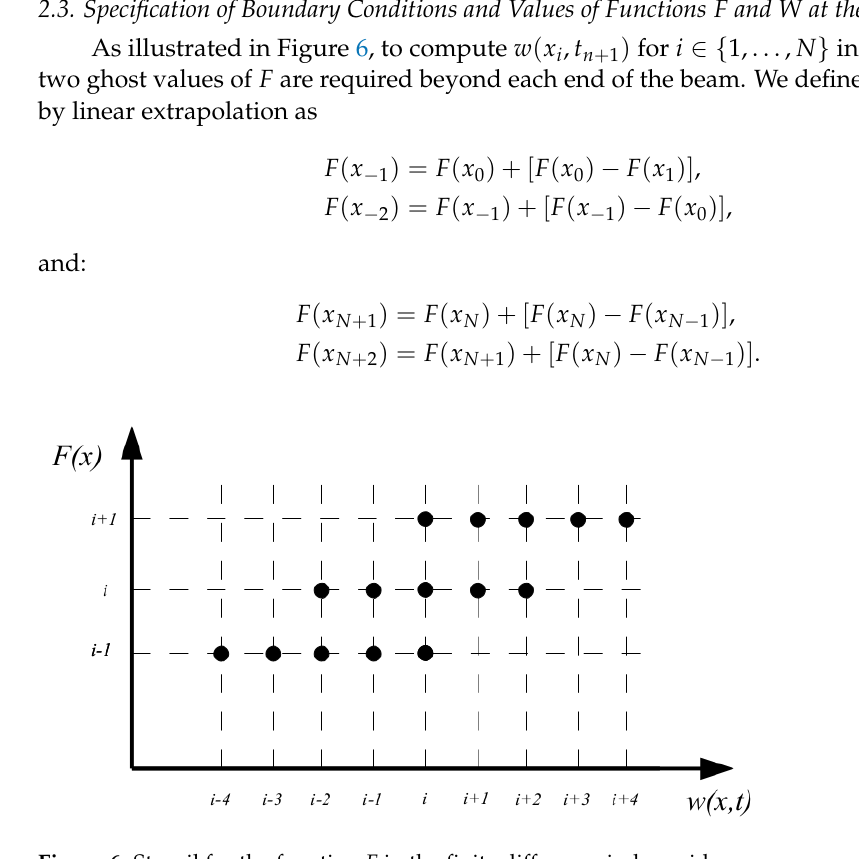
Figure 6. Stencil for the function F in the finite difference index